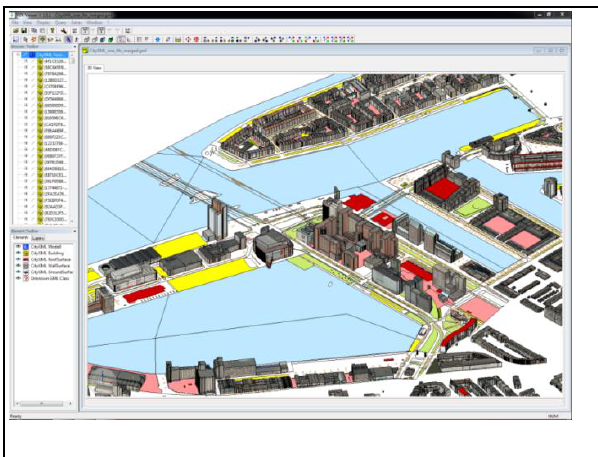
Figure 3: Visualisation of CityGML-IMGeo encoded data: CityGML